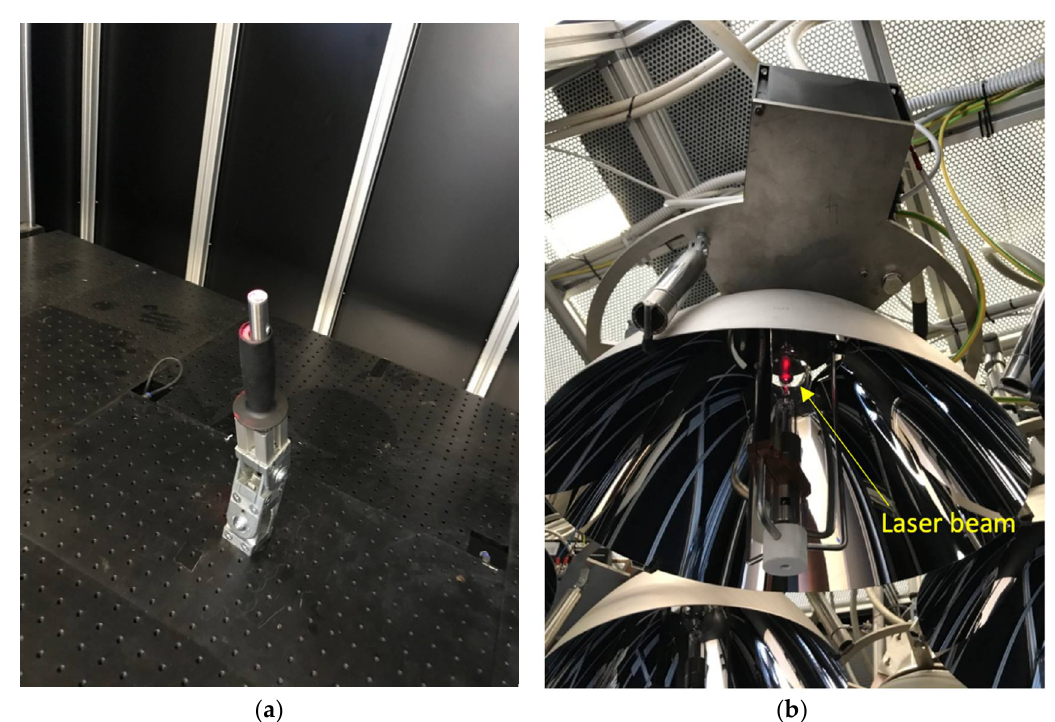
Figure 11. Pictures of the HFSS: ( a ) laser mounted in the center of the table; ( b ) alignment of a lamp with laser beam (red spotlight) in the focus.